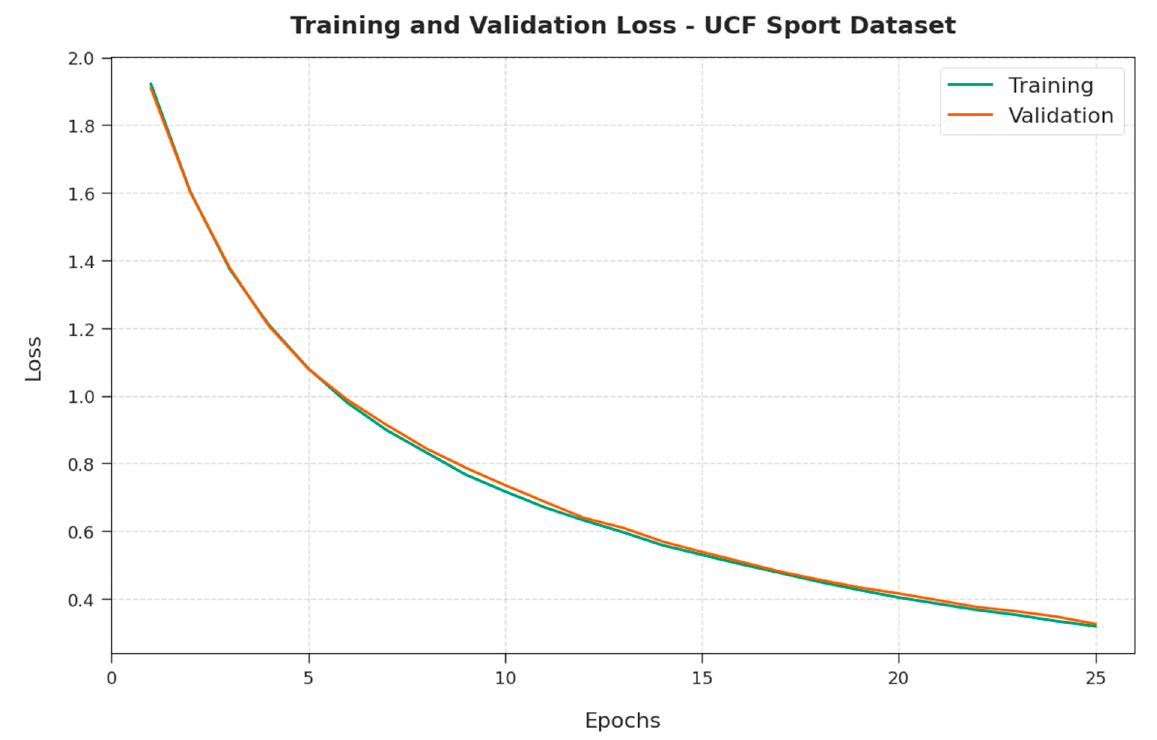
Figure 8. Training and validation accuracies of QWSA-HDLAR model on KTH dataset.